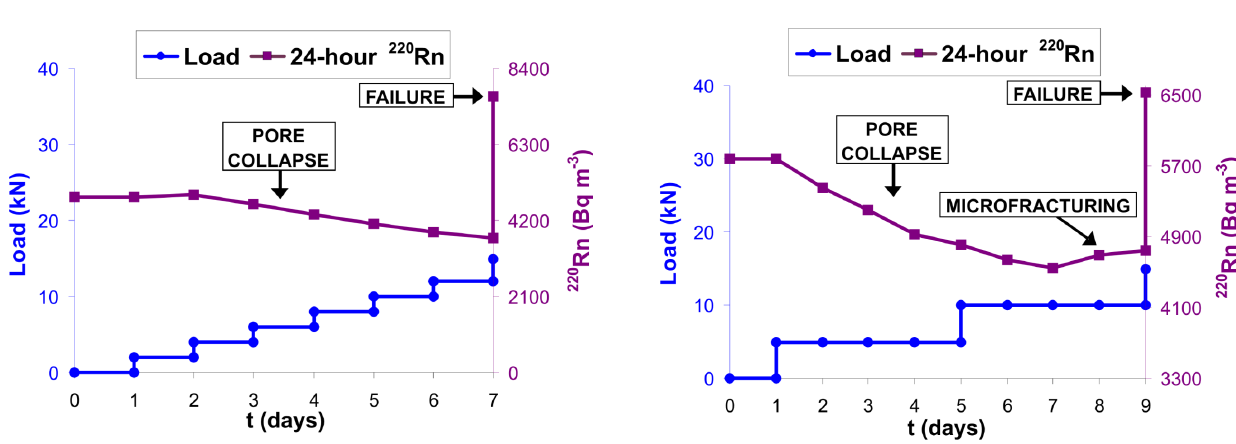
Figure 5. DDRC experiment R2, at constant temperatures of 90 ◦ C. The uniaxial load and 24h average 220 Rn activity concentration are plotted versus the experimental time. Two load steps from 0 to 5kN and from 5 to 10kN were performed. For each step the load was kept constant for 4 days. 220 Rn concentration progressively de- creases over time accounting for a pore collapse process. However, at 10kN, the thoron signal slightly increases the day before the rup- ture. This is due to the formation of microfractures, anticipating the macroscopic failure that occurs at about